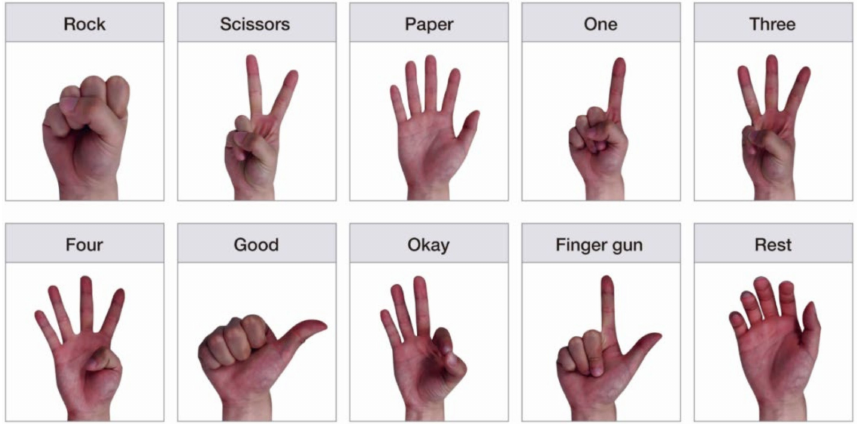
Figure 3. Ten hand and finger gestures used for classification. Two whole-hand gestures (rock and paper) and seven IF gestures (scissors, one, three, four, good, okay, and finger gun) are included. The subjects were asked to perform the gestures in the order shown in Figure